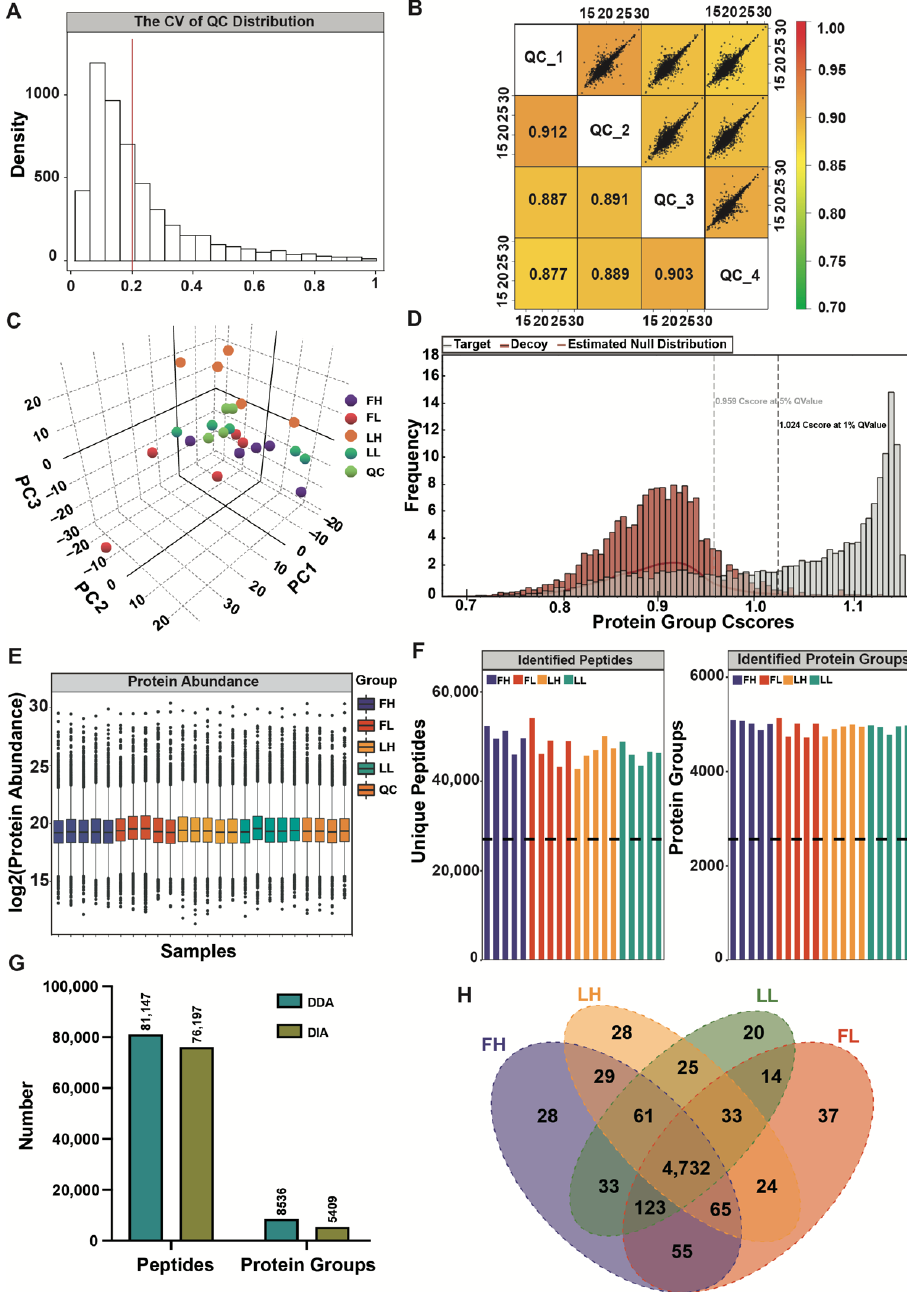
Figure 1. Overview of quality control (QC) and quantitative proteomics. ( A ) The coefficient of variation (CV) of QC distribution. ( B ) Correlation analysis of QC samples; the correlation coefficient close to 1 indicates that the system is more stable. ( C ) 3D Principal component analysis (PCA) of the quantified proteins for each QC sample. ( D ) Protein FDR analysis; the 1% Q Value is used as the qualitative threshold, which corresponds to FDR 0.01, red is the distribution of decoy (anti-library), gray is the target (positive library), C-score means the protein confidence score, and a higher C-score at 1% Q Value indicates a better result. ( E ) The quantitative intensity distribution of all samples and QC samples. ( F ) Statistics of the peptides and proteins identified in each sample; the dotted line represents the number of proteins or peptides at 50% of the total maximum number of identifications. ( G ) Comparison of peptides and proteins in data-dependent acquisition (DDA) and data-independent acquisition (DIA) strategies. ( H ) Venn diagram of proteins in different groups.